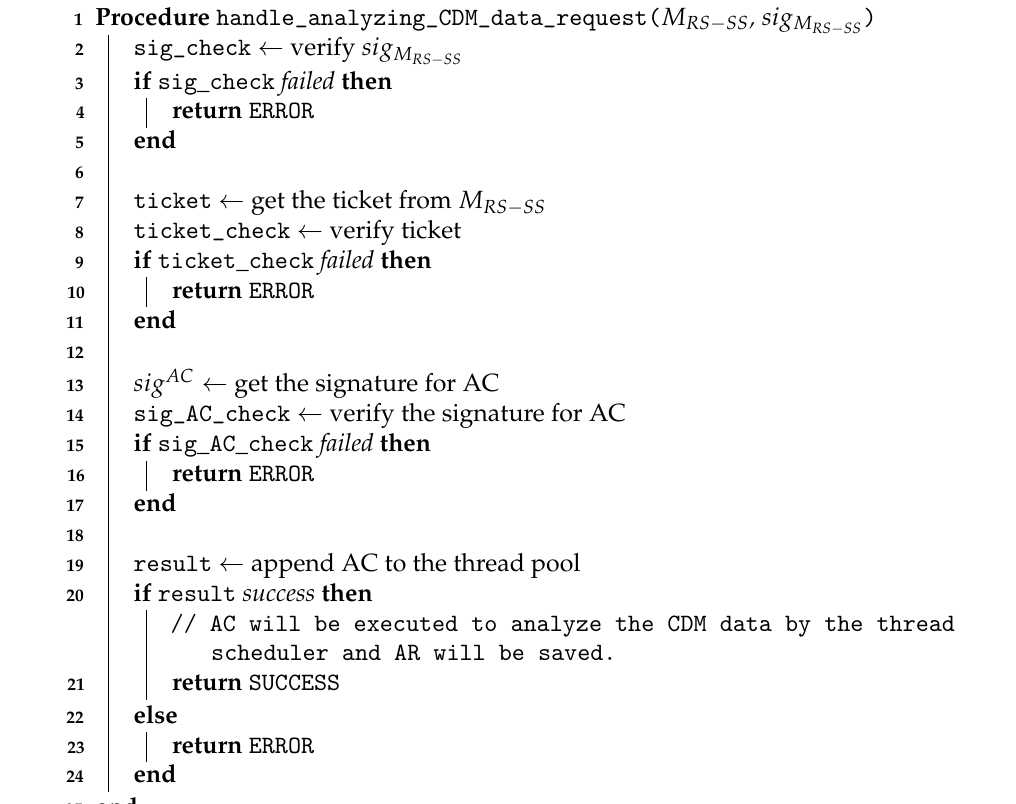
Algorithm 9: The AC distributing algorithm on the SS